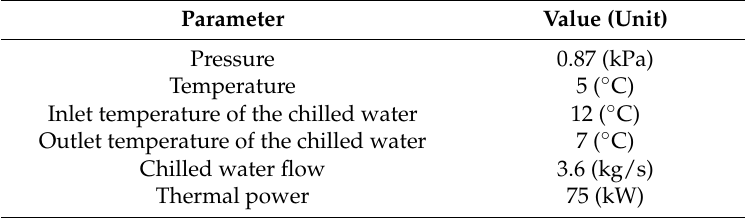
Table A2. Nominal calculation values of the evaporator by thermodynamics